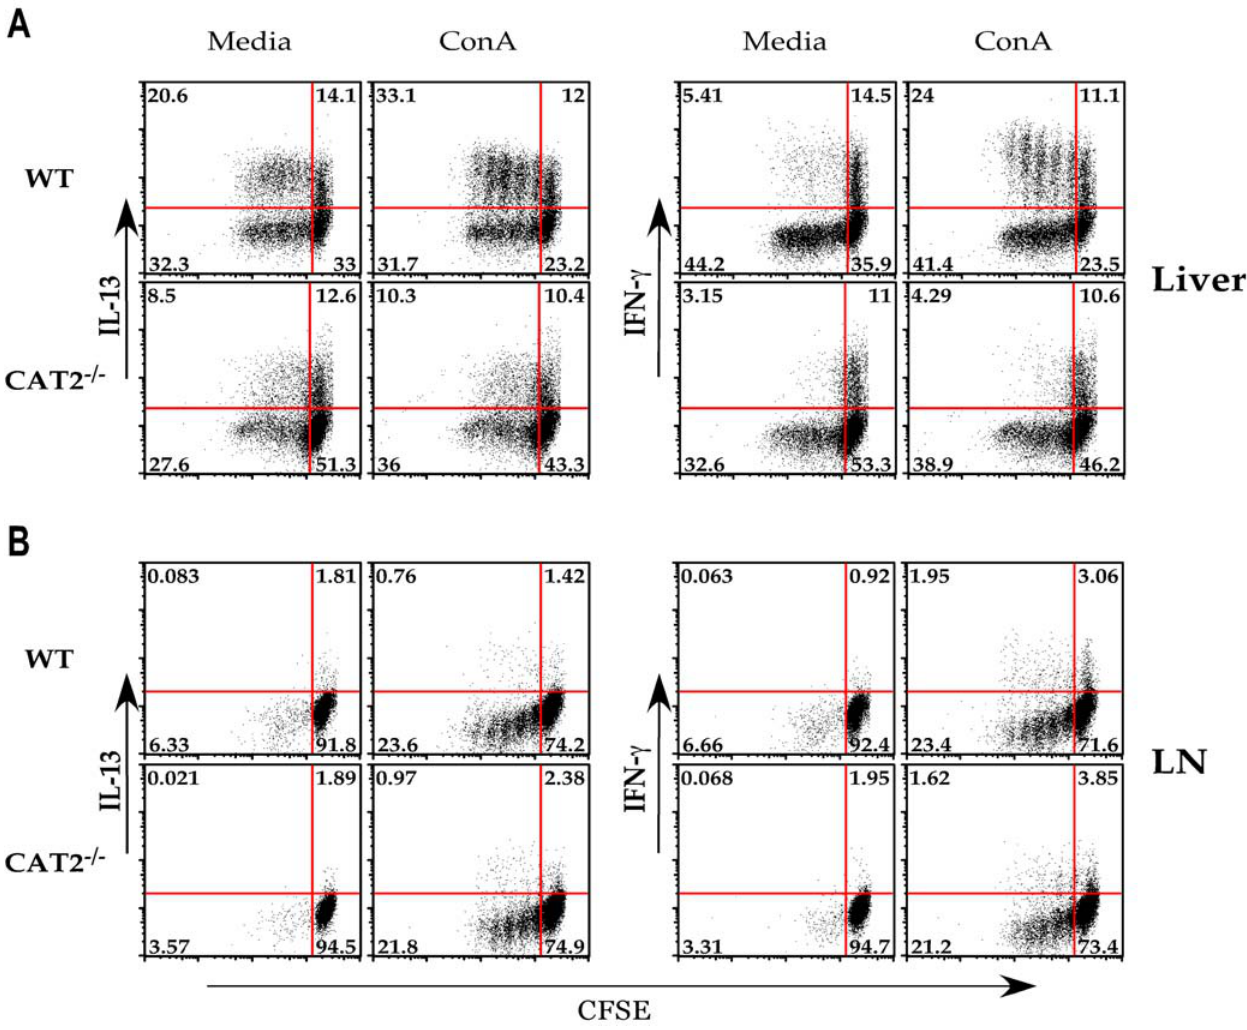
Figure 6. Cytokine production and proliferation of CD4 + lymphocytes is impaired in the granulomatous tissues of infected CAT2 2 / 2 mice. A. Leukocytes derived from the granulomatous livers of 8 wk infected WT C57BL/6 and CAT2 2 / 2 mice were stained with CFSE and cultured for 72 hrs in the presence of media alone or Con A (1 m g/ml). Cells were subsequently stained for IL-13 (left panels) and IFN- c (right panels). Representative FACS plots are shown. The experiment was repeated numerous times with similar results. B. Mesenteric lymph node cultures from 8 wk S. mansoni infected WT and CAT2 2 / 2 mice.